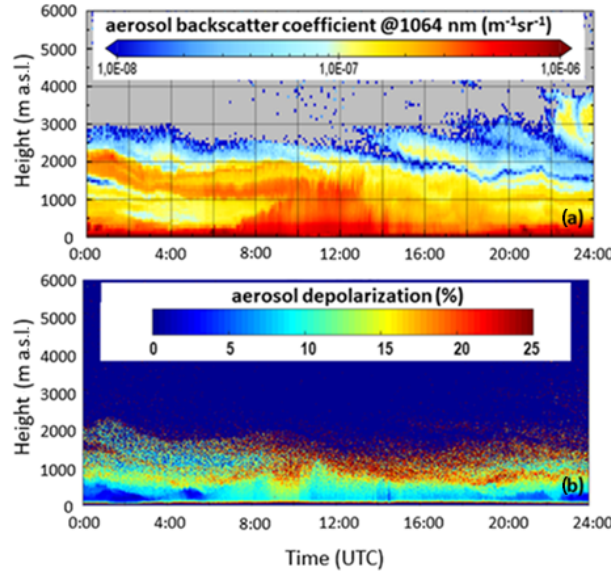
Figure 30. Aerosol profile measurements performed in Rome (Italy) on 11 July 2017 by the Automated LIdar-CEilometer net- work (ALICEnet). Aerosol backscatter coefficient (m − 1 sr − 1 ) at 1064nm (a) and aerosol depolarisation in % (b)